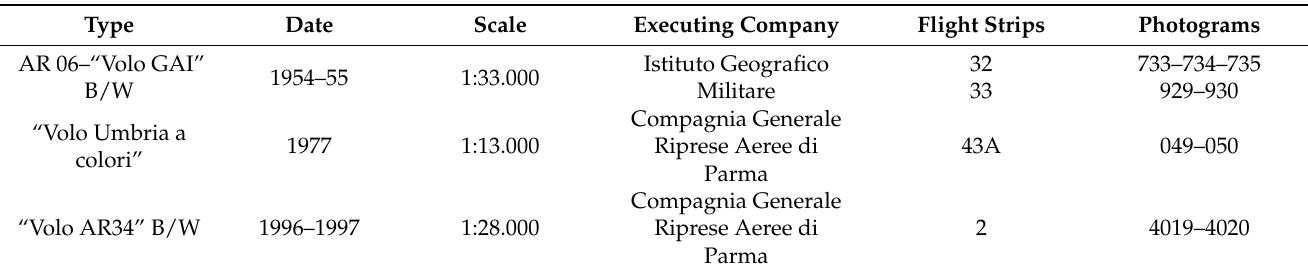
Table 2. Characteristics of the imagery database used in the study